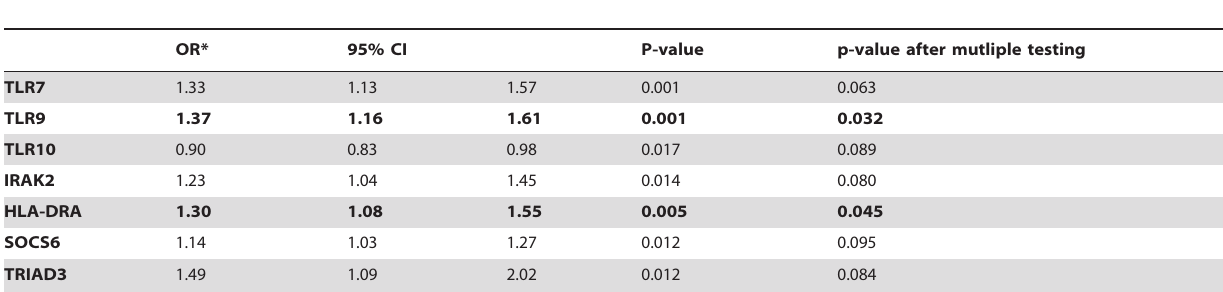
Table 3. Association of PRR and molecules of the TLR signaling cascade with CSR to IgE.